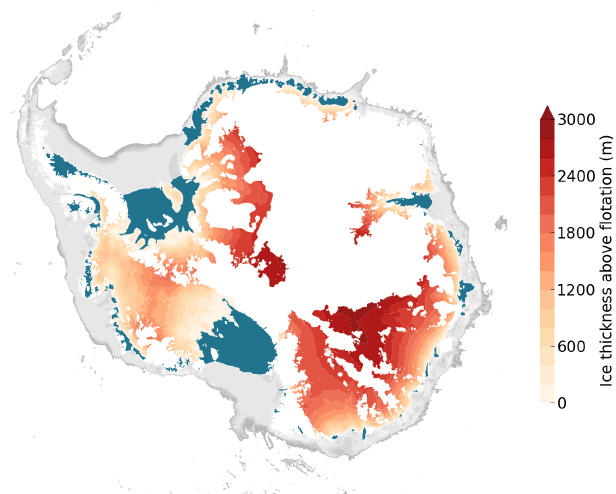
Figure A1. Ice thickness above flotation of marine regions (bedrock below sea level) that are connected to the ocean (color bar). Ice shelves are in blue, and the continental shelf is in grey. Ice and bed topography are taken from the BEDMAP2 compilation (Fretwell et al., 2013).